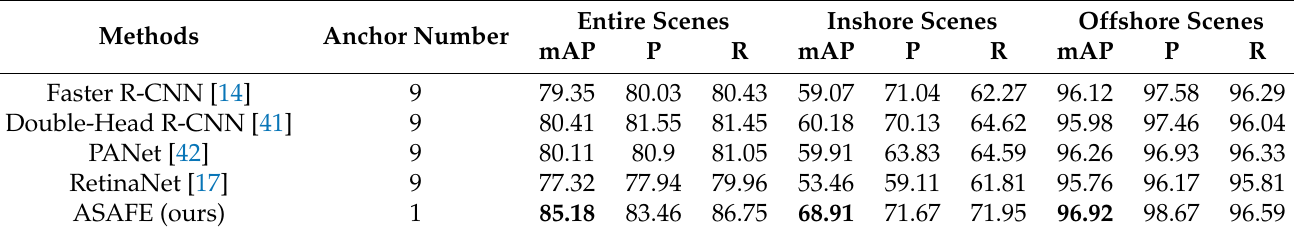
Table 8. Comparisons of different methods on the HRSID